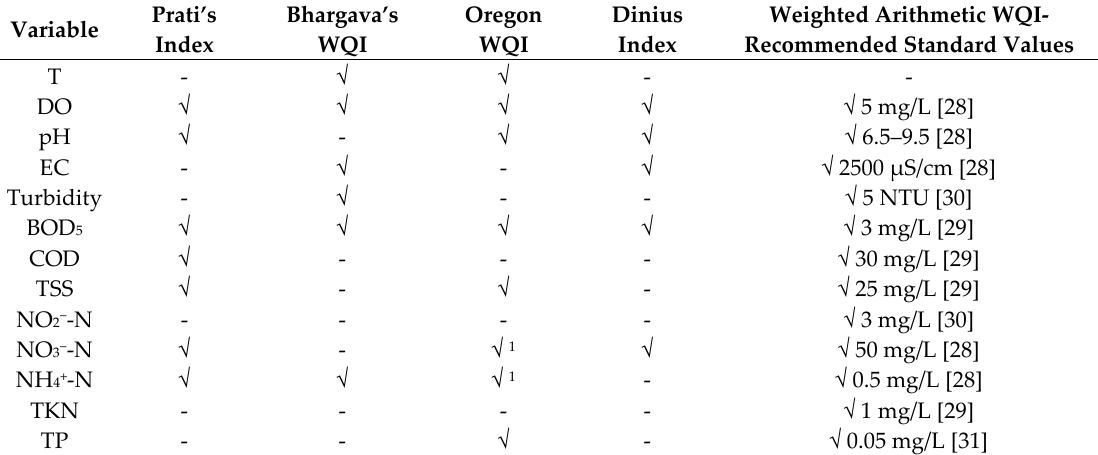
Table 1. Selected parameters taken into consideration in the computation of the individual